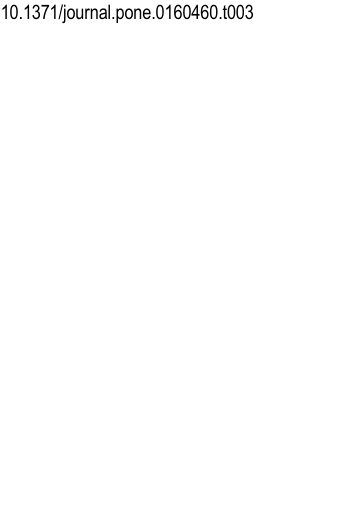
Viral load (HIV-1 RNA